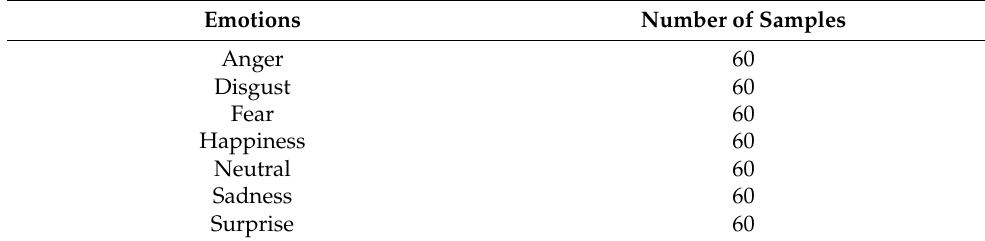
Table 1. Data samples distribution per emotion in the